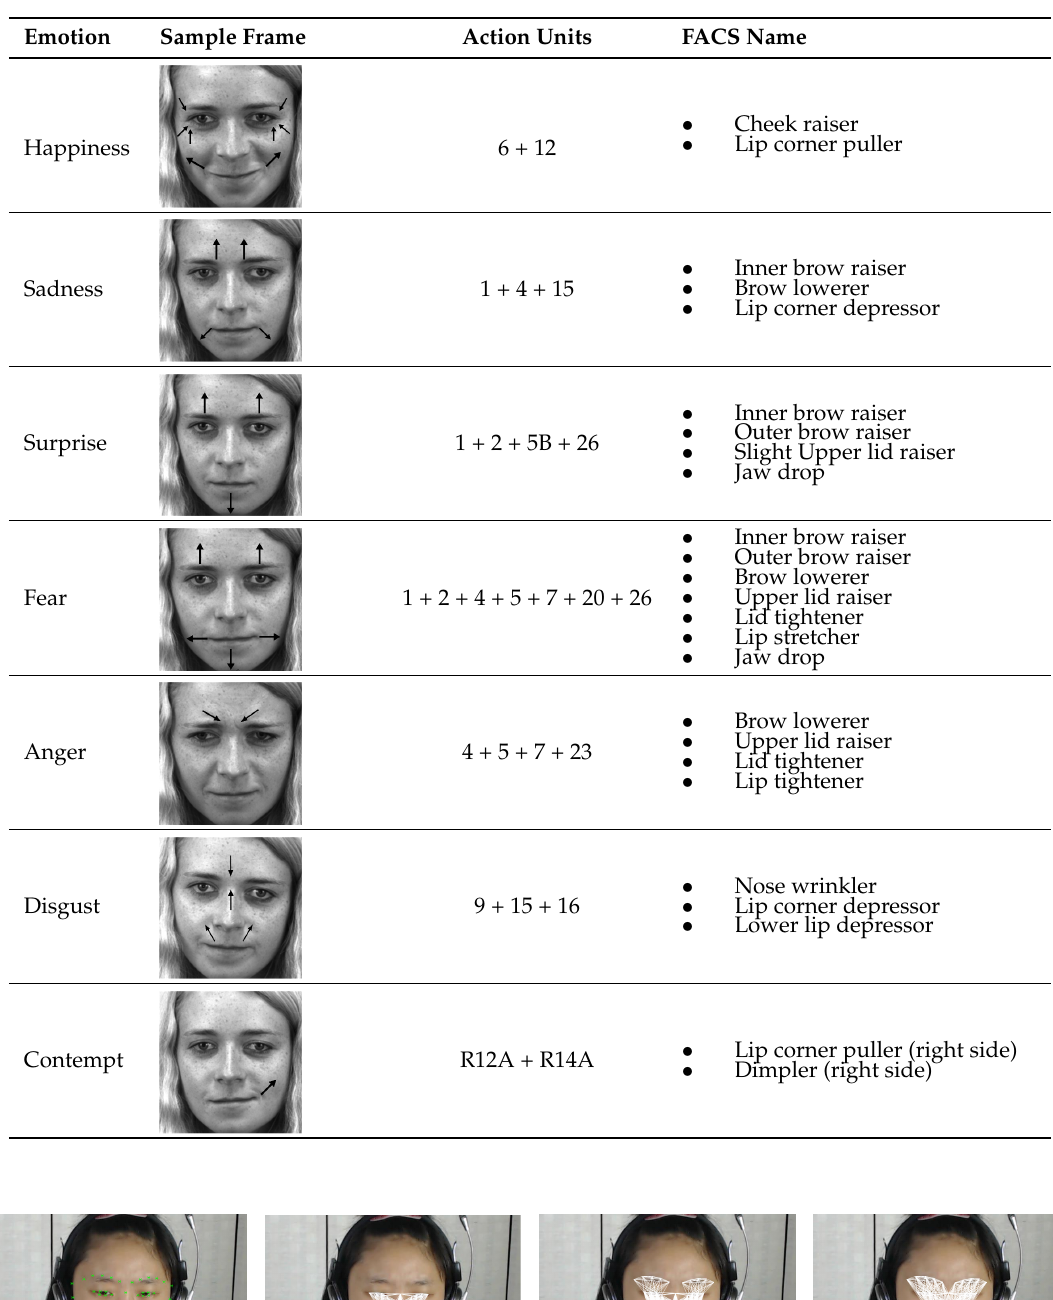
Table 3. AUs for Different Emotions.